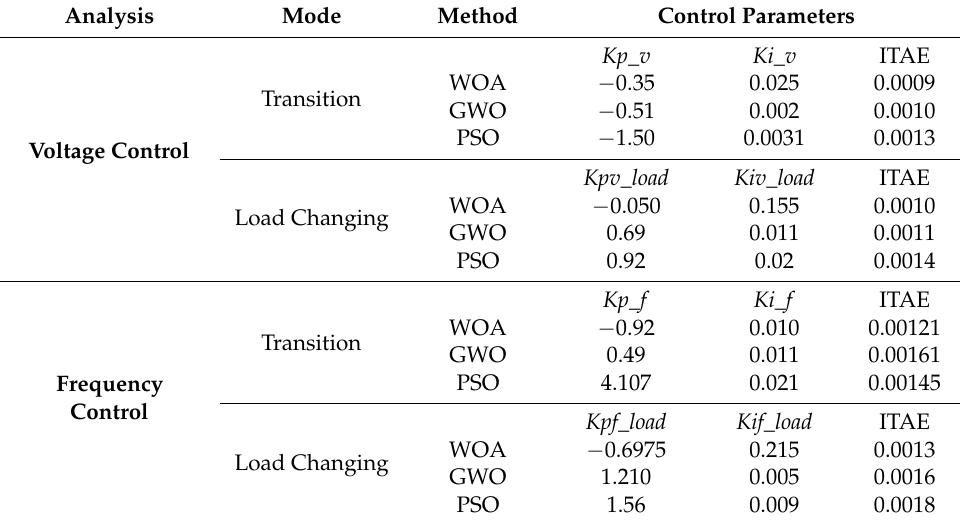
Table 2. Optimal parameters obtained by optimization techniques in both cases.